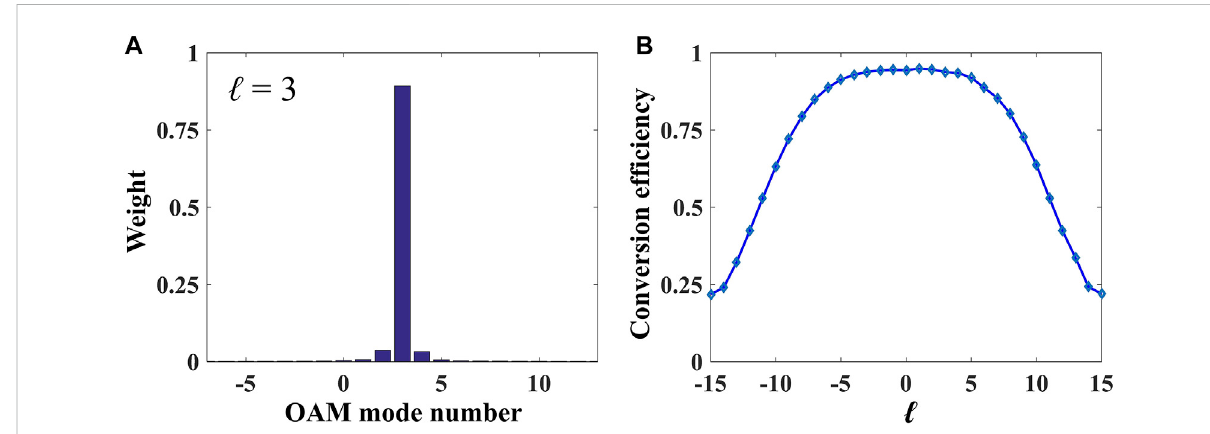
FIGURE 4 Purity of the generated vortex beams. (A) The OAM spectrum of output beam with ℓ = 3. (B) Conversion ef fi ciency of vortex beam versus ℓ